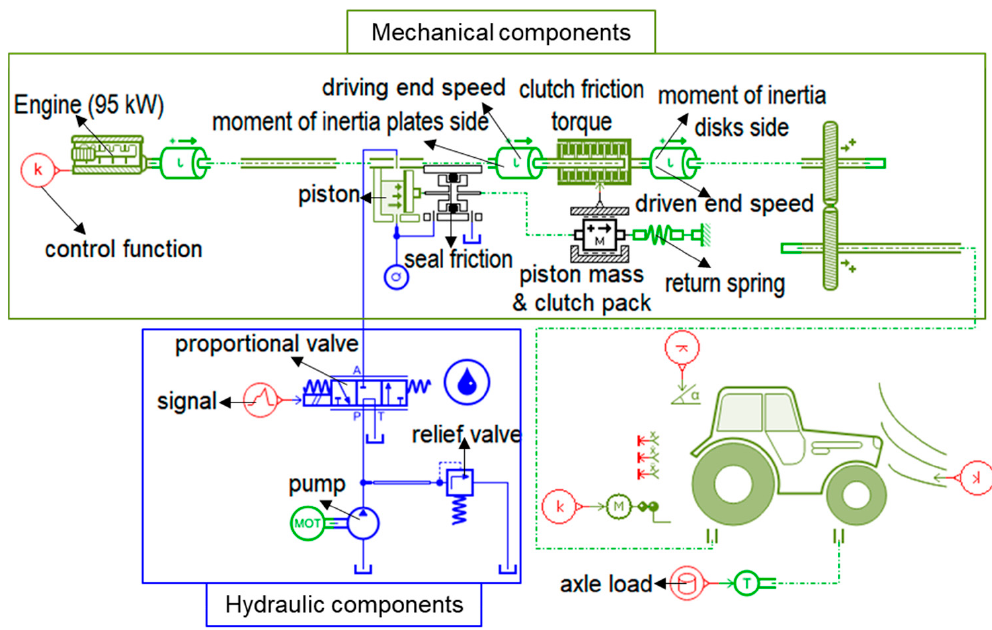
Figure 4. The simulation model of the hydraulic clutch pack for the PST.